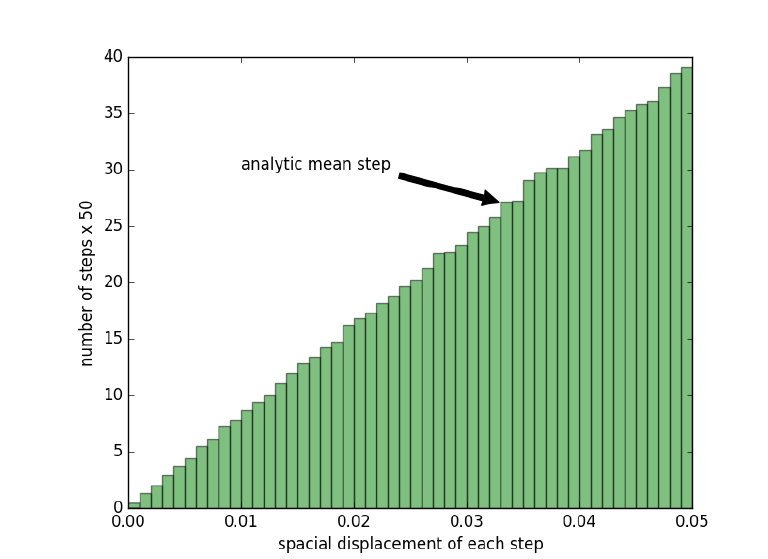
Figure 5. A bar graph showing the spatial displacement of the random walker after each step on a network with 10 4 nodes and r c = 0.05. There are 10 5 steps, and each bar corresponds to the number of steps ( × 50), where the spatial displacement of the random walker is in the range of 10 − 3 . Afterwards, Equation (1) is evaluated considering a network with 1000 nodes and radius r c =